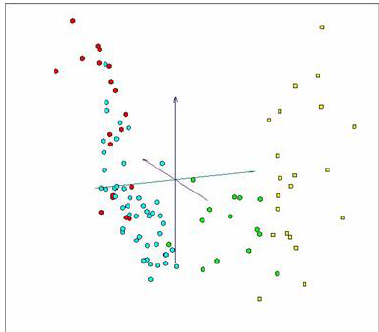
Figure 4. Source data in the space of the first principal components